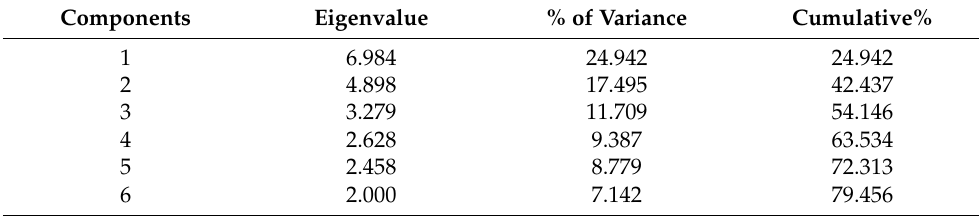
Table 4. Total variance and components extracted by the varimax rotating